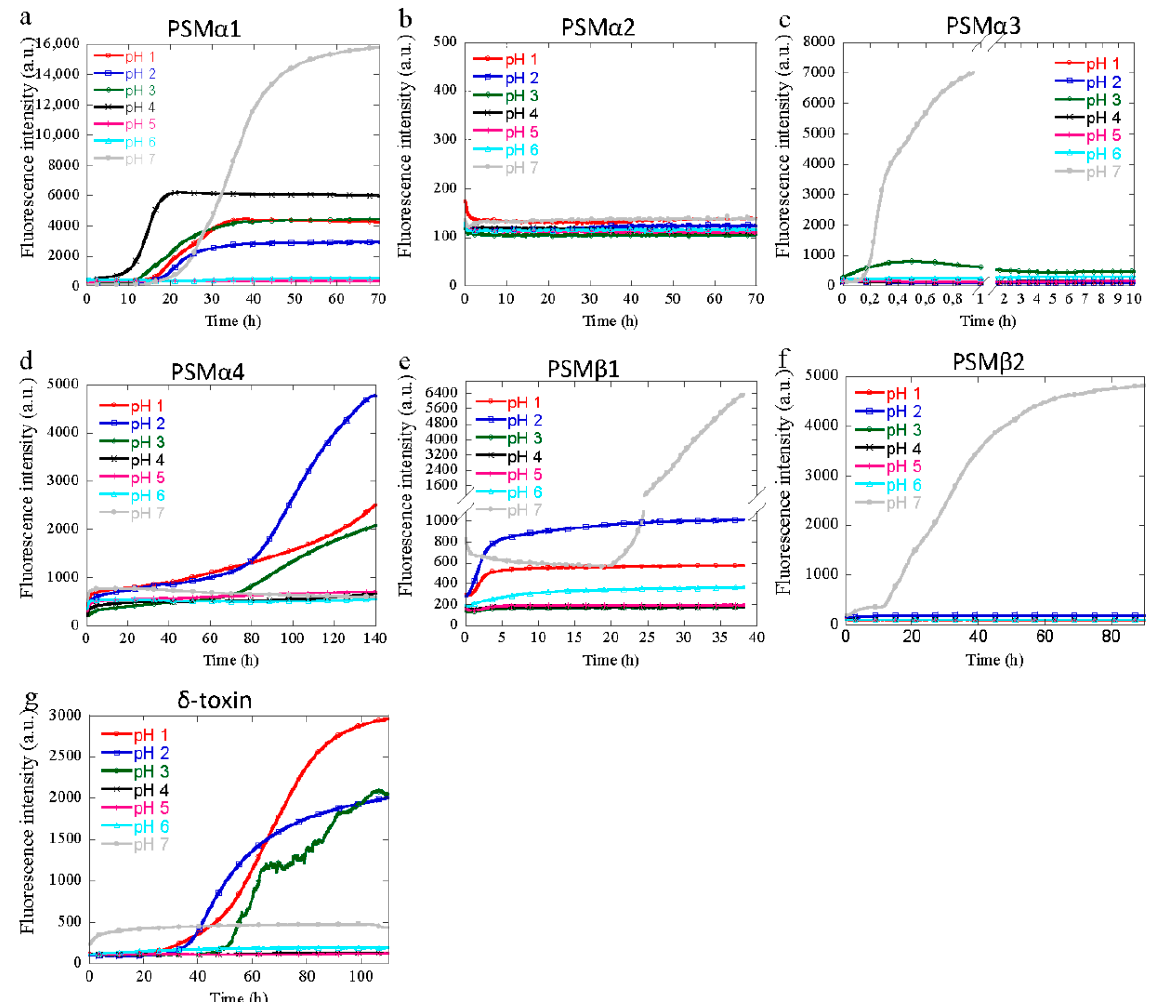
Figure 1. Experimental kinetics of PSM aggregation at 37 ◦ C every 10 min under quiescent conditions for single monomeric concentration at acidic and neutral (pH 1–7) solution conditions followed by ThT fluorescence. Three repeats were carried out at each condition. ( a ) Aggregation kinetics of PSM α 1 (0.25 mg/mL). ( b ) Aggregation kinetics of PSM α 2 (0.25 mg/mL). ( c ) Aggregation kinetics of PSM α 3 (0.5 mg/ml). ( d ) Aggregation kinetics of PSM α 4 (0.25 mg/mL). ( e ) Aggregation kinetics of PSM β 1 (0.25 mg/mL). ( f ) Aggregation kinetics of PSM β 2 (0.25 mg/mL). ( g ) Aggregation kinetics of δ -toxin (0.3 mg/mL).